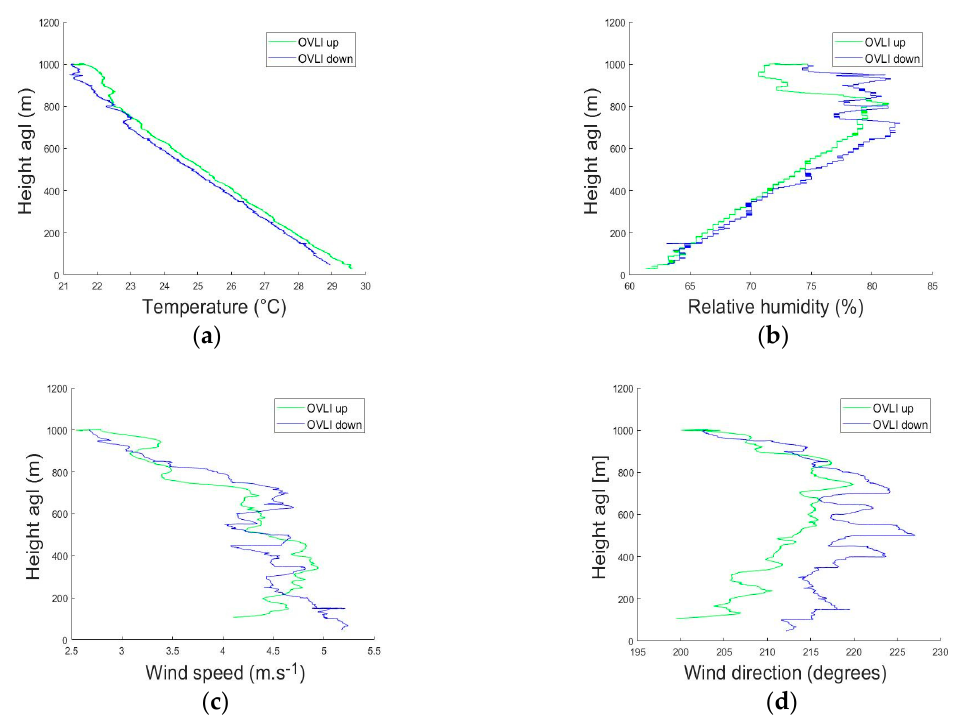
Figure 14. Profiles of temperature ( a ), relative humidity ( b ), wind speed ( c ), and wind direction ( d ) measured during ascending (in green) and descending (in blue) flight sequences on July 15, 2016.